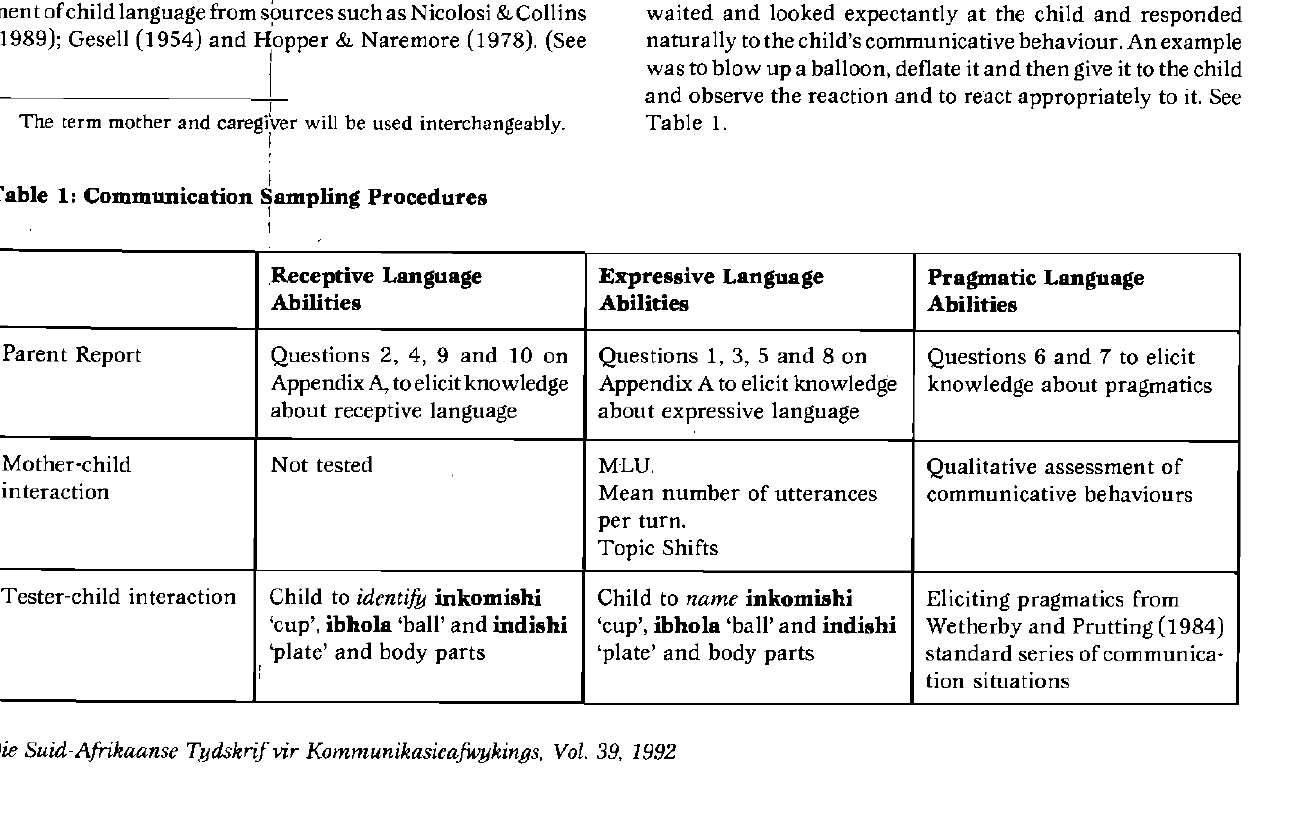
Table 1: Communication Sampling